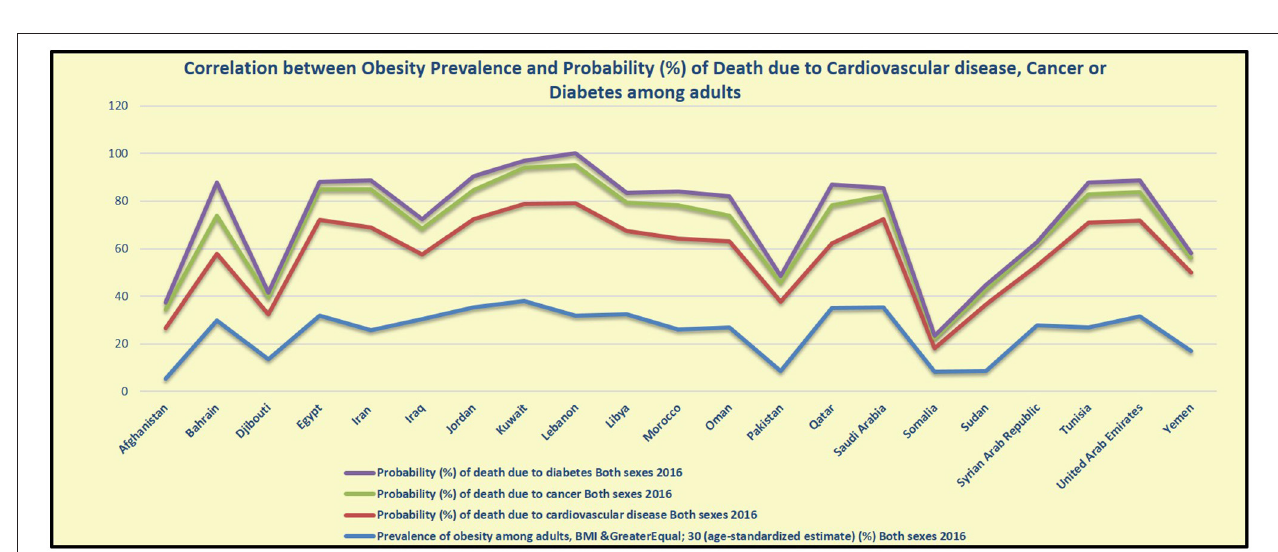
FIGURE 4 | Correlation between the prevalence of obesity, diabetes, and cumulative cancer risk among adults in EMR (6, 26).